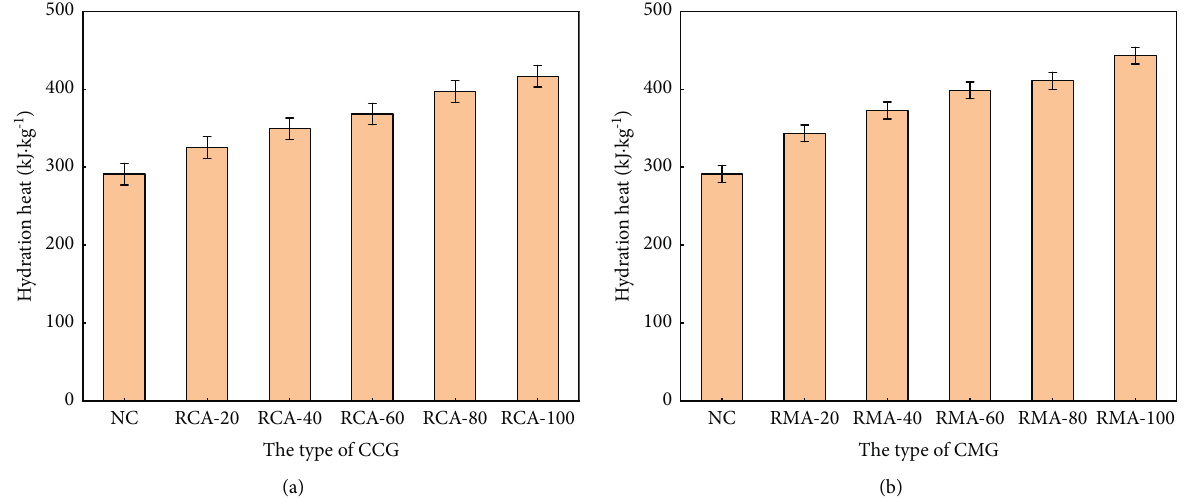
Figure 3: The effect of RCA and RMA with different dosages on hydration heat of CCG and CMG. (a) CCG, (b) CMG.